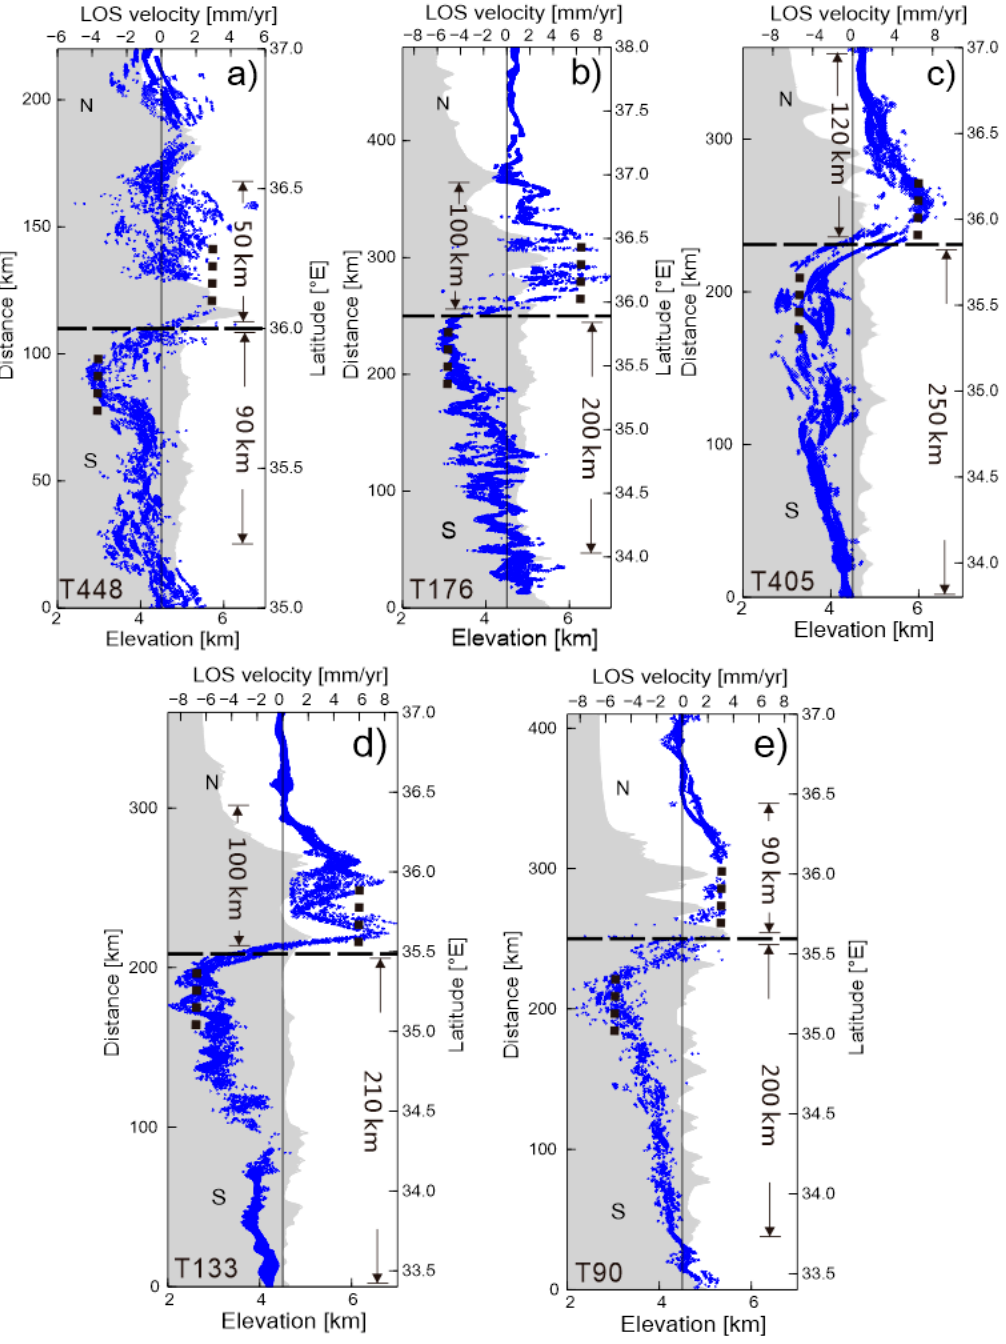
Figure 6. Fault-perpendicular profiles of postseismic LOS velocities (2003–2010) within 10 km along the five lines described in Figure 5, 448 ( a ), 176 ( b ), 405 ( c ), 133 ( d ) and 90 ( e ). The black arrows delimit the approximate width of the near-fault postseismic deformation zone on the southern (S) and northern (N) sides of the KF (represented by black dashed line). The black dashed lines indicate approximate location of peak velocity values on either side of the fault.